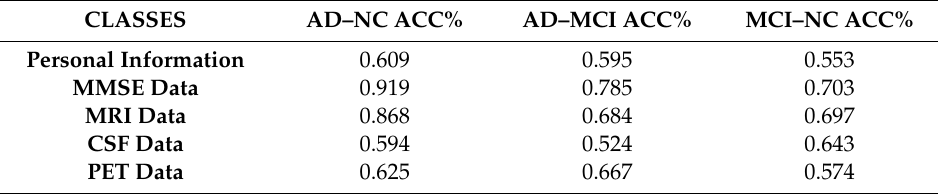
Table 5. Accuracy of AD, MCI, and NC classification, using each group of data, alone.